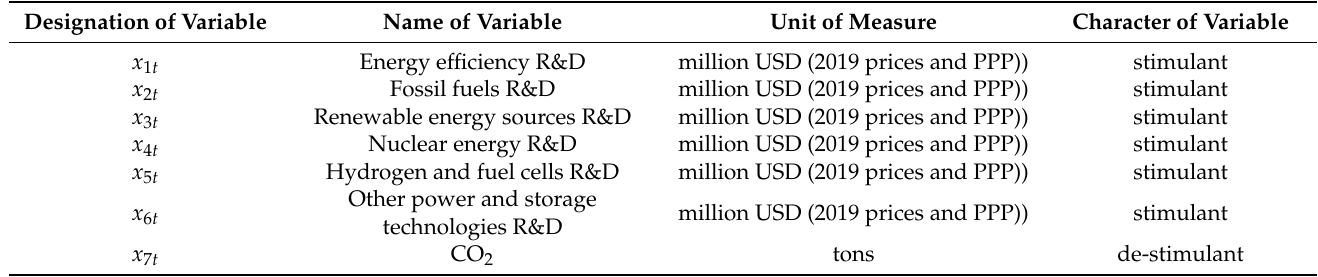
Table 2. Definition of